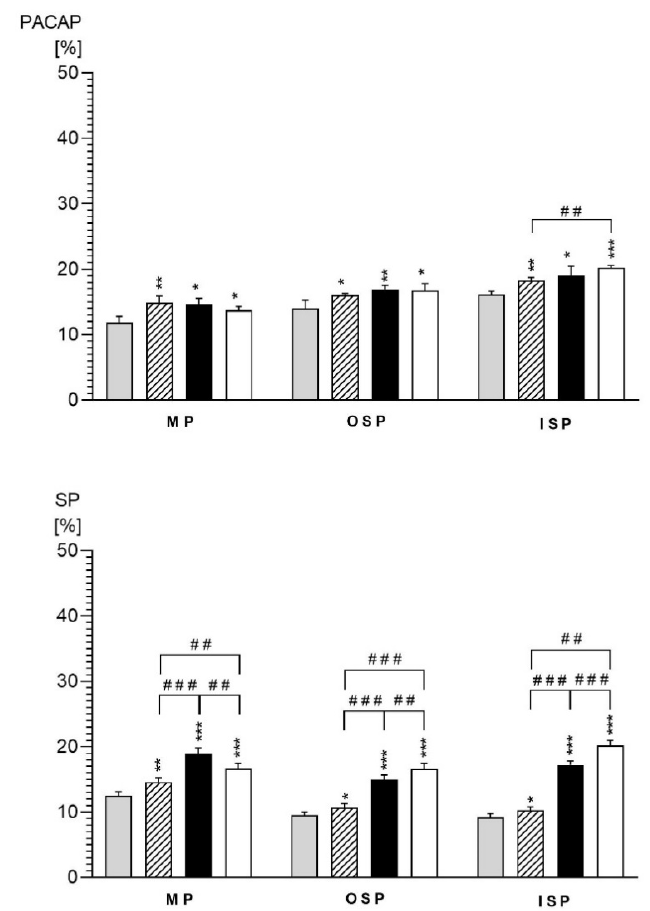
Figure 2. Percentages of PACAP-, GAL- and SP-LI perikarya in the wall of the jejunum in the control (grey bars), aspirin (hatched bars), indomethacin (black bars) and naproxen (white bars) animals. * p < 0.05, ** p < 0.01, *** p < 0.001—indicate differences between the C group and experimental groups for the same neuronal populations; # p < 0.05, ## p < 0.01, ### p < 0.001—indicate differences between ASA vs. INDO vs. NA for population of GAL-, PACAP- and SP-positive neurons in MP, OSP and ISP .